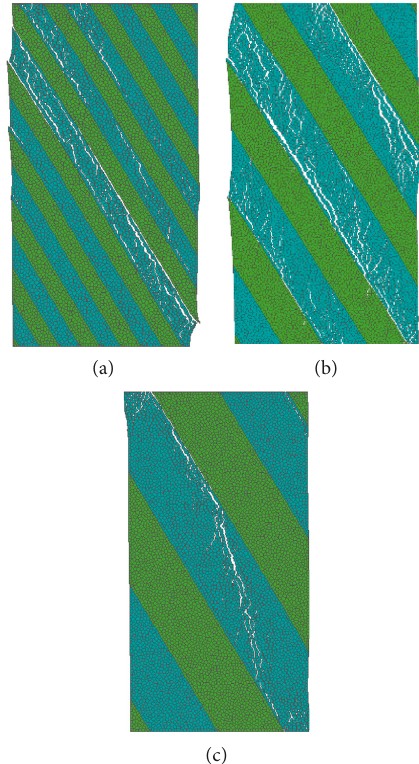
Figure 14: Failure mode of specimens at α layer thickness under uniaxial compression: (a) d d 16.67cm; (c) d (cid:29)